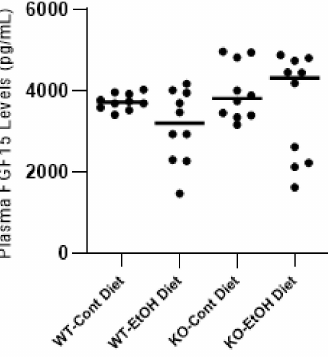
Figure 5. Plasma FGF15 levels in mice quantified by ELISA ( n = 10 per group). p < 0.05 was considered significant. Cont, control diet; EtOH, ethanol diet; KO, Abcb4 knockout mice; WT, C57BL/6J wild-type mice.